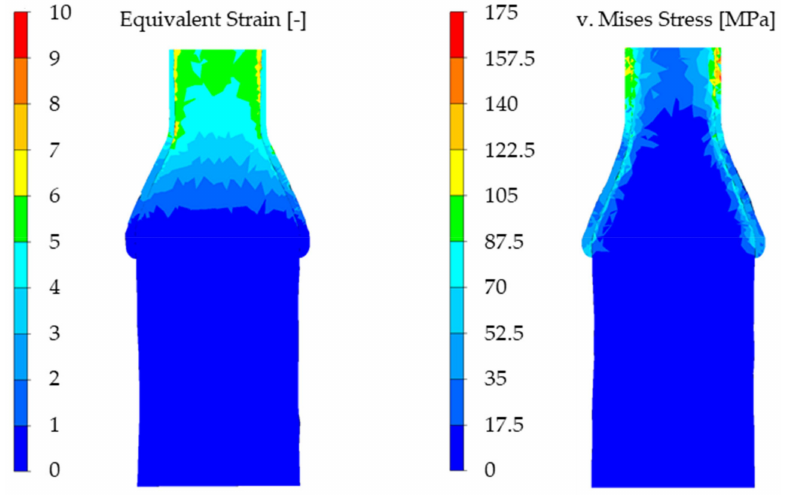
Figure 9. Equivalent strain and v. Mises stress shortly before the end of the forming process.